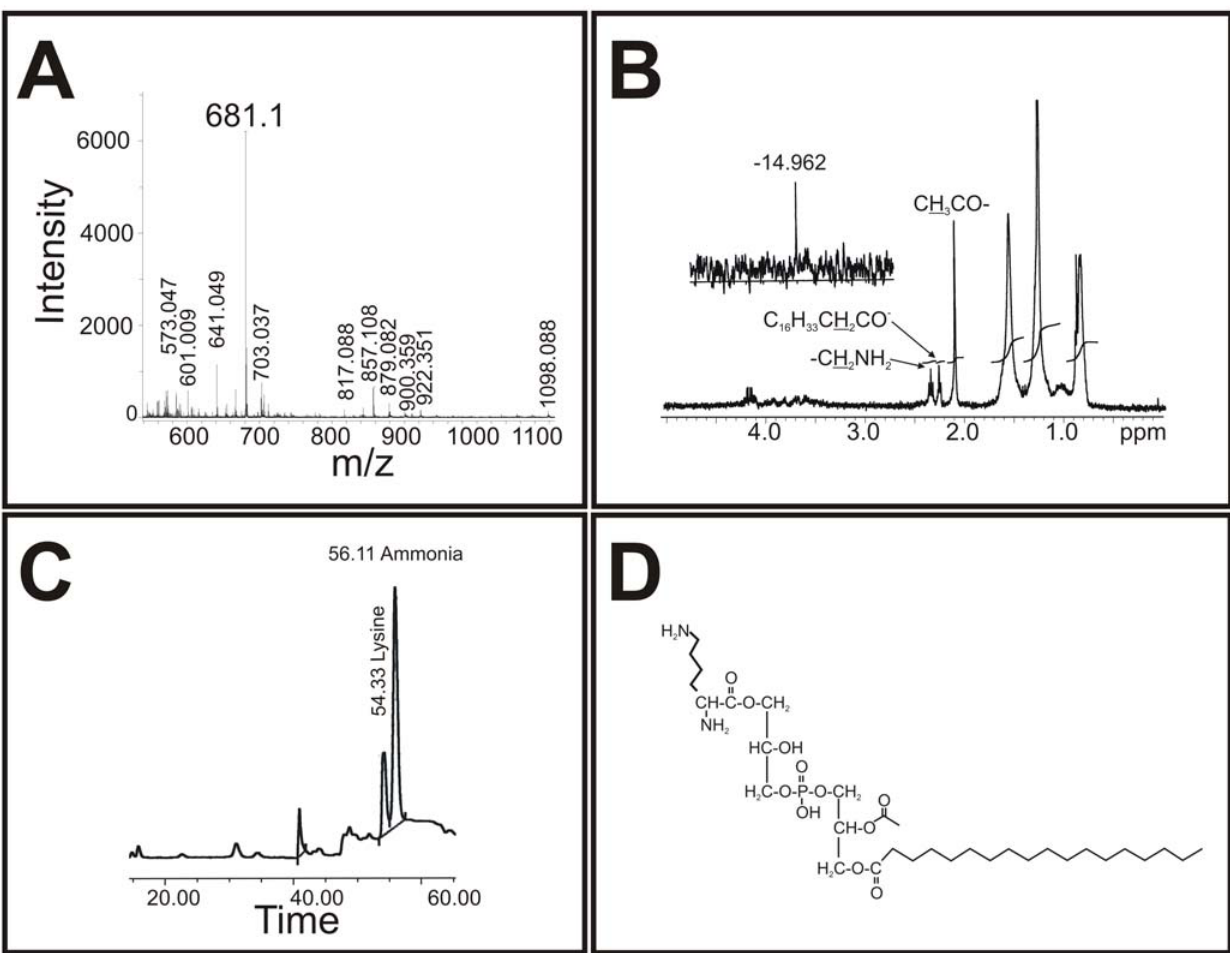
Figure 2. Structural analysis of L-PoL. A: MALDI mass spectrometry analysis of L-PG in negative-ion mode. The m/z 681 [M-H] 2 represented the molecular ion peak. B: Structural analysis of L-PG. 1 H-NMR spectrum of L-PG. The acetyl group can be found at d CH3 2.1 ppm, and d CH2 from the primary amine in lysine was detectable at 2.4 ppm. The inset shows the 31 P-NMR spectrum, in which the phosphorus resonance shifted at 2 14.96 ppm. C: The amino acid profile of L-PG. Pure lipid was hydrolyzed with 6 N HCl for 24 h, and the soluble hydrolytic product was analyzed in an amino acid analyzer. Note that the elution of lysine at 54.33 min coincides with the standard (not shown). The small peak at position 41 min corresponds to a buffer change during the run, and the ammonia peak at 56.11 min is from the buffer used to run the analyzer. D: The proposed L- PG structure. The proposed structure of L-PG with a C 18 fatty acid identified from fatty acid analysis (data not shown).